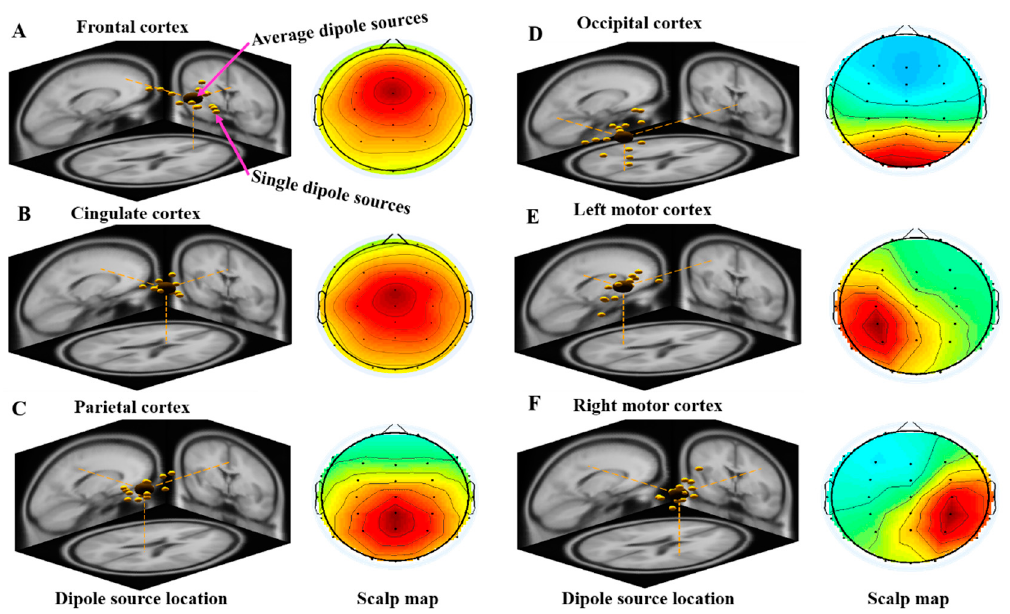
Figure 3. EEG dipole-source location and scalp map of six clusters including ( A ) frontal cortex (14Ss, 14ICs), ( B ) cingulate cortex (13Ss, 13ICs), ( C ) parietal cortex (14Ss, 14ICs), ( D ) occipital cortex (16Ss, 16ICs), ( E ) left motor cortex (15Ss, 15ICs) and ( F ) right motor cortex (15Ss, 15ICs). We represent subjects (Ss) and independent components (ICs) in each cluster. Yellow dots indicates the individual dipole source location of each subject; the large dark dot indicates the average dipole source location of all